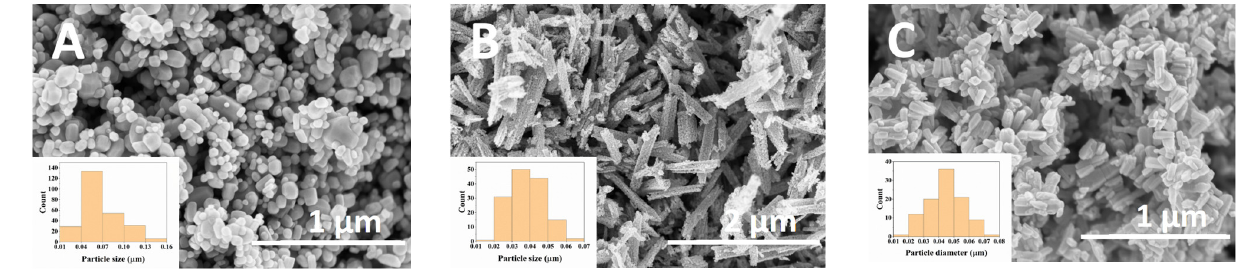
Figure 3. SEM images of No. 1 ( A ), No. 2 ( B ), and No. 3 ( C ) ZnO